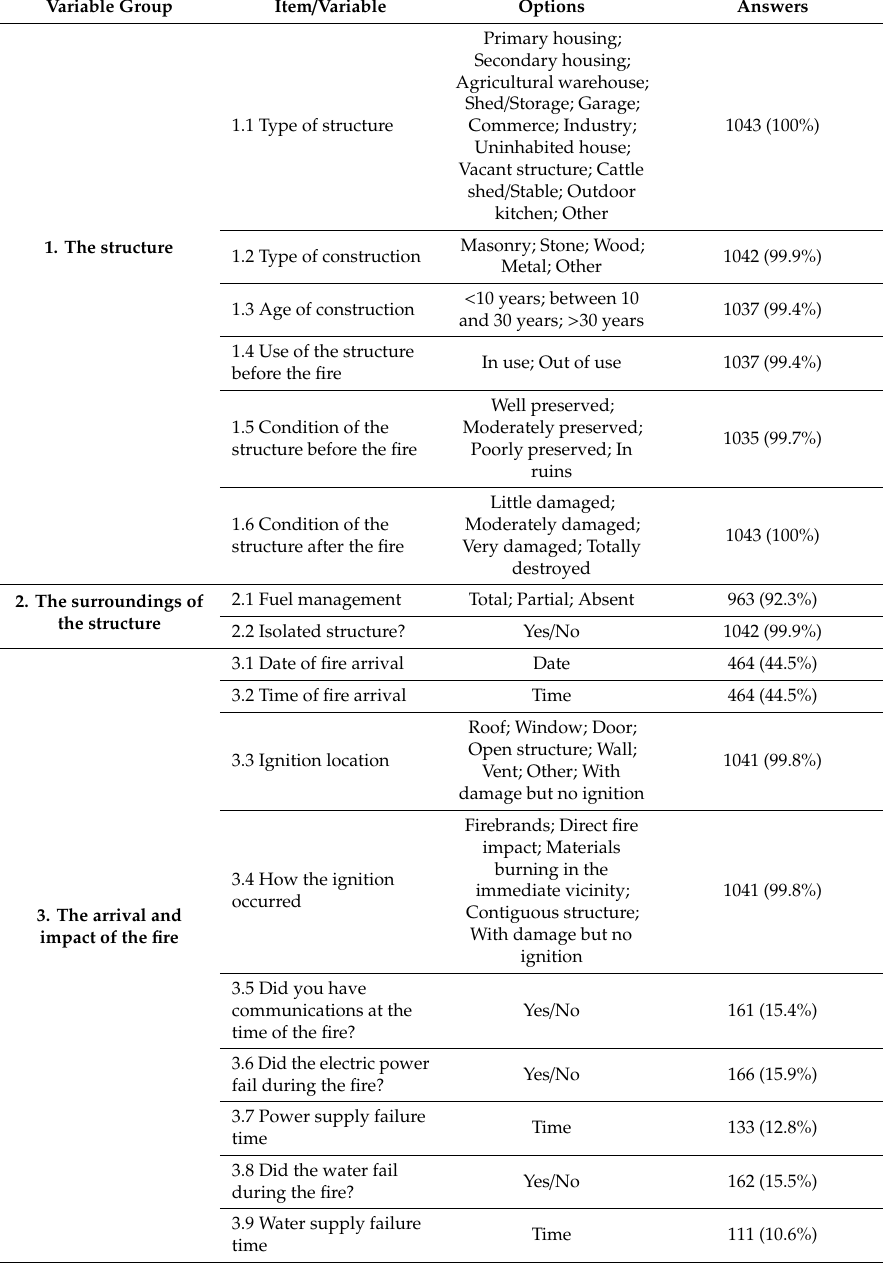
Table 1. Variables used in the field work, the corresponding answer options, and the ratio of answers